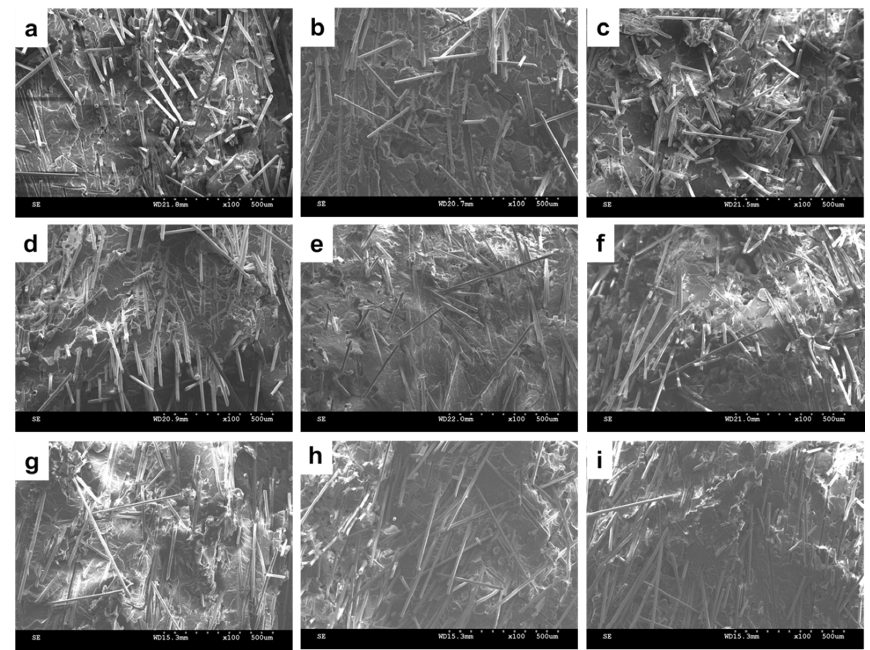
Figure 9. SEM images (100×) of PP/SGF composites, which are incorporated with ( a ) 0 wt % of a coupling agent; ( b ) 2 wt %; ( c ) 4 wt %, ( d ) 6 wt %; and ( e ) 8 wt % of PP-g-MA; as well as ( f ) 2 wt %; ( g ) 4 wt %; ( h ) 6 wt %; and ( i ) 8 wt % of SEBS-g-MA.